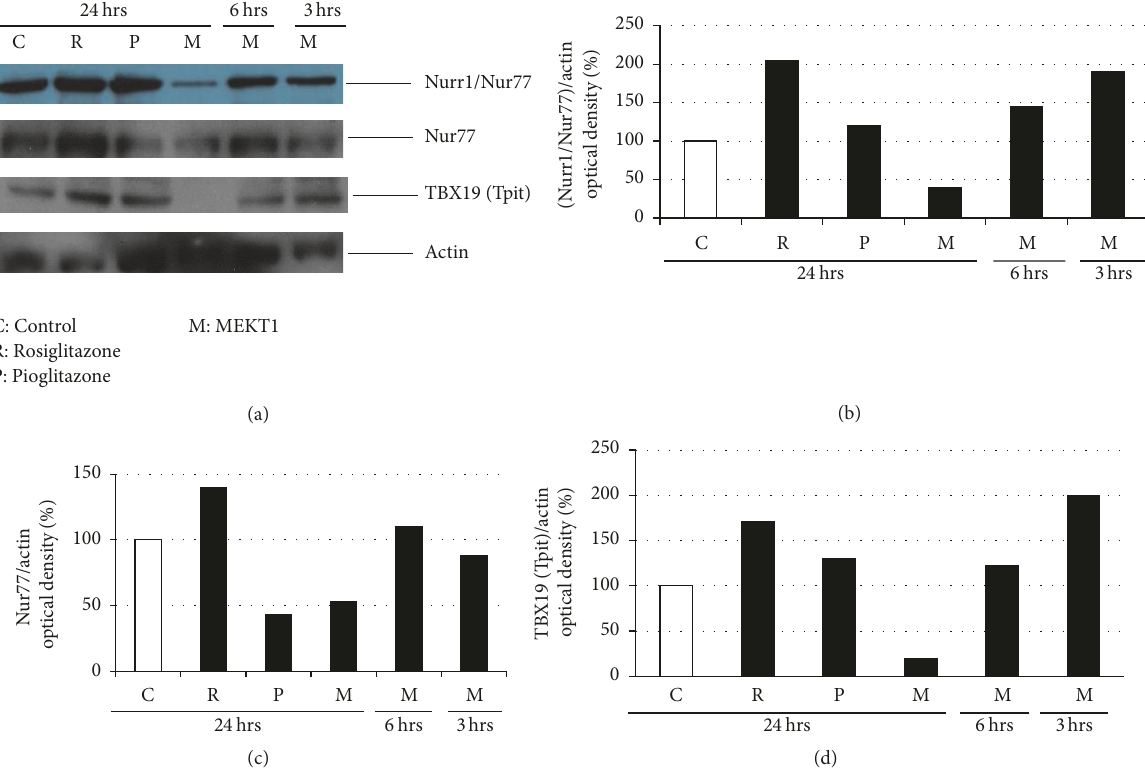
Figure 8: Effects of MEKT1 (time dependently), rosiglitazone, and pioglitazone on Nurr1, Nur77, and Tpit protein expression. (a) AtT20 cells treated with MEKT1 (M) at 10 𝜇 M for 24 hours, 6 hours, and 3 hours, rosiglitazone (R) at 10 𝜇 M for 24 hours, and pioglitazone (P) at 10 𝜇 M for 24 hours, or 0.1% DMSO as control (C) for 24 hours. Optical density (OD) of Nurr1/Nur77 was shown in figure (b), Nur77 in figure (c), and TBX19 (Tpit) in figure (d). OD of Nurr1/Nur77, Nur77, and TBX19 (Tpit) were normalized by OD of actin. Results are expressed as percentages of control